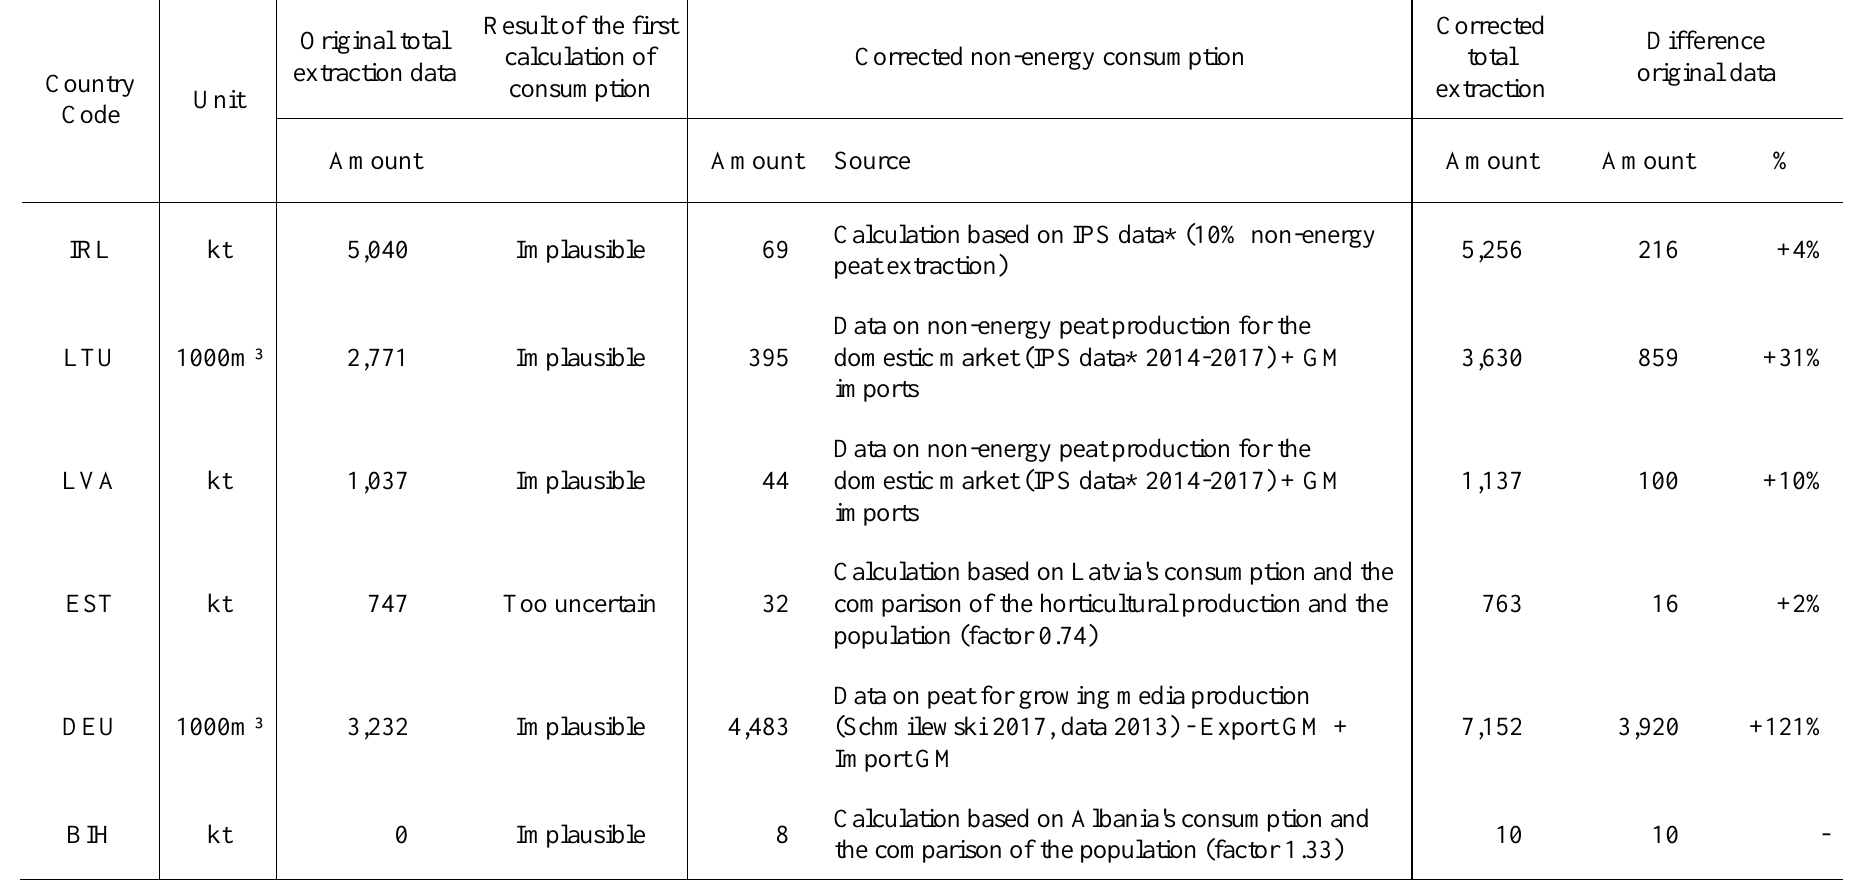
Table A8. Calculation of consumption and correction of non-energy extraction data. GM = Growing Media; * = personal communication (2019).